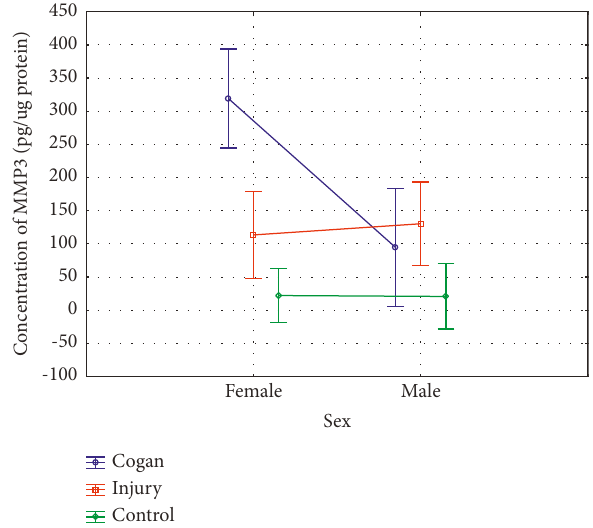
Figure 5: Assessment of the influence of sex and group on the values of MMP-3